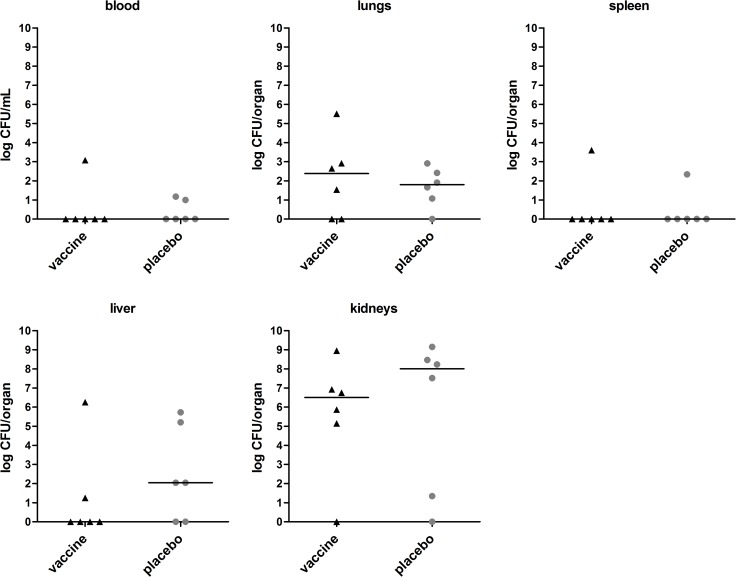
Bacterial load in immunized mice with S. aureus isolate P bacteremia.Mice (n = 8) were immunized with the octa-valent vaccine containing IsaA-His6, LytM-His6, Nuc-His6, His6-pro-Atl, and PSMα1-4, or with placebo. Animals were infected by intravenous inoculation of S. aureus isolate P (3 × 105 CFU). At day 14, surviving mice were sacrificed and quantitative cultures of blood, lungs, spleen, liver, and kidneys were performed. Each symbol represents a single mouse. Median values are indicated by horizontal lines. Statistically significant differences in S. aureus load were not observed (P > 0.05; Mann-Whitney U test).